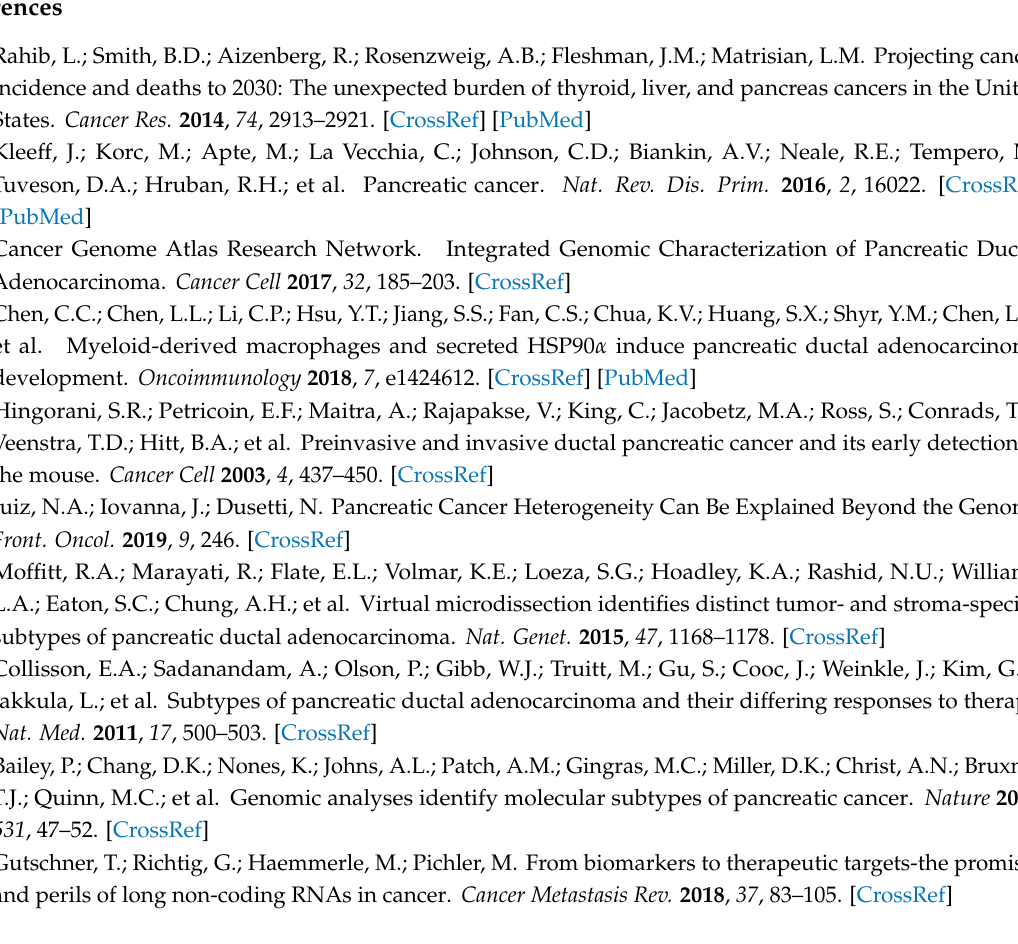
s1, Figure S1: Differential expression of lincRNAs in PDAC subtypes, Figure S2: LincRNAs with prognostic relevance across all TCGA PAAD samples, Figure S3: LincRNAs with subtype-specific prognostic relevance in TCGA PAAD samples, Figure S4: M8 stem loop and its putative interaction partners, Figure S5: Potential targeting of selected lincRNAs by microRNAs, Figure S6: Putative interactions between selected lincRNAs and protein-coding transcripts, Table S1: Differential expression of lincRNAs in PDAC, Table S2: LincRNA expression in PDAC-derived cell lines, Table S3: 27 selected lincRNA candidates, Table S4: Correlation coefficients of the 27 selected lincRNA candidates, Table S5: Predicted TF bindings, Table S6: Predicted RNA RBP interactions, Table S7: Predicted miRNA interactions, Table S8: GSEA results of correlation between selected lincRNAs and protein coding genes in classical PDAC, Table S9: GSEA results of correlation between selected lincRNAs and protein coding genes in basal-like PDAC, Table S10: Predicted mRNA interactions in classical PDAC, Table S11: Predicted mRNA interactions in basal-like PDAC, Table S12: Differential expression of lincRNAs in KRAS wild type vs KRAS mut PDAC